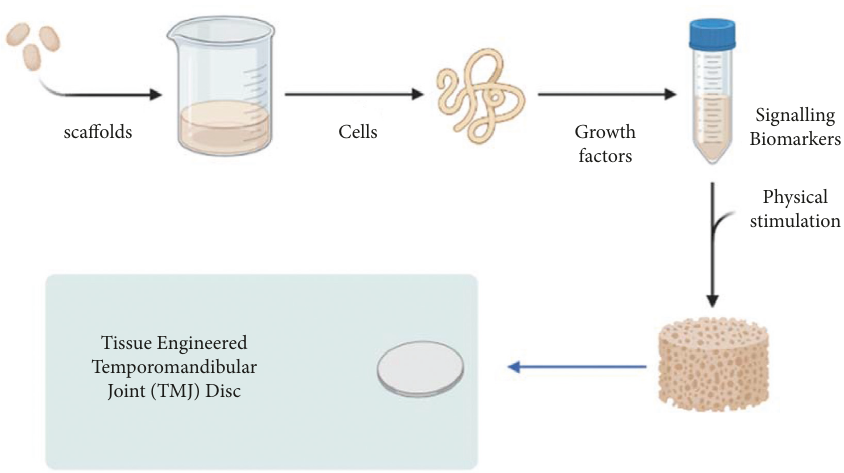
Figure 1: Steps and components of tissue engineering the TMJ